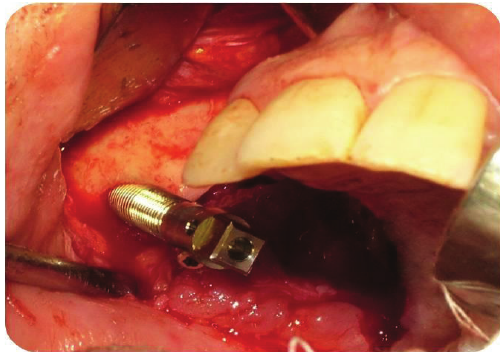
Figure 5: Implant placement of zygomatic